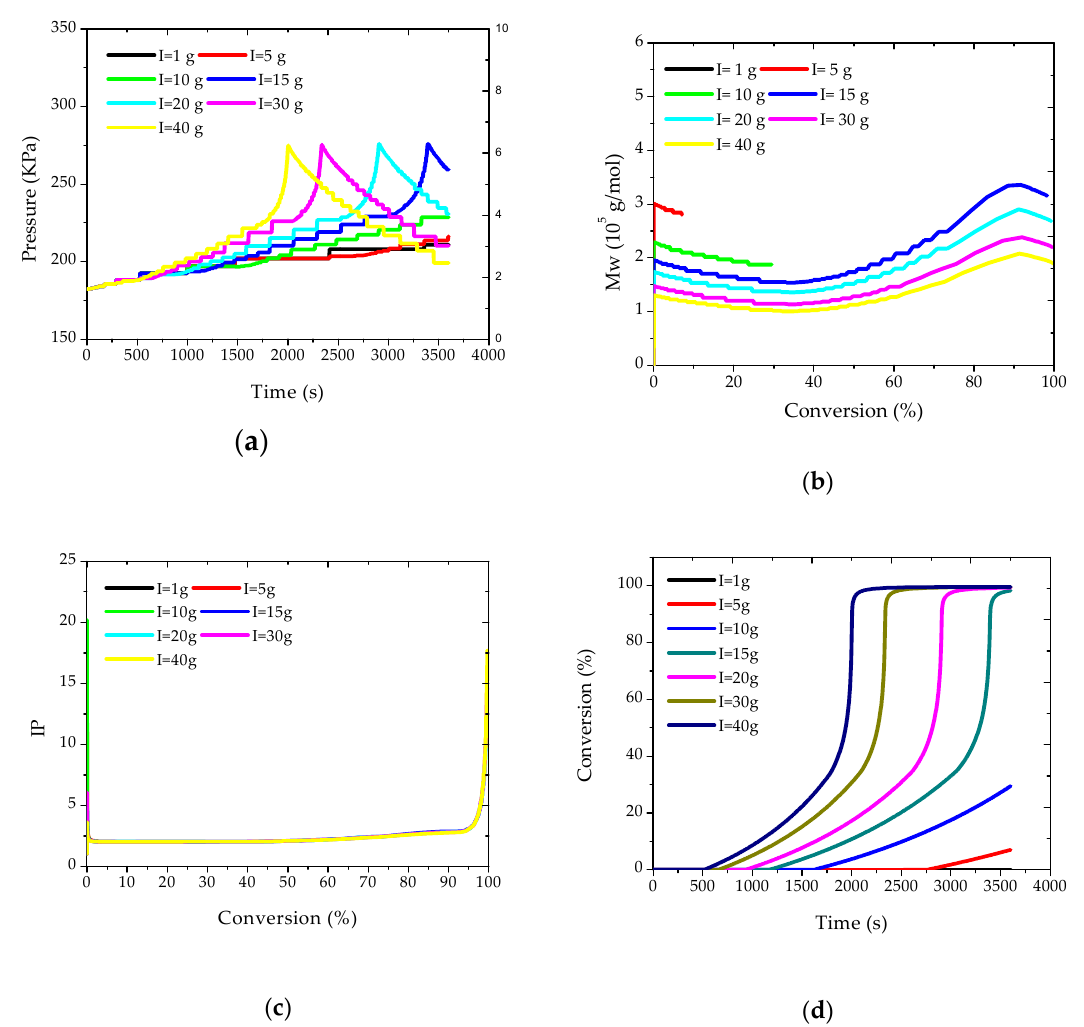
Figure 3. ( a ) Pressure; ( b ) Mw; ( c ) IP; and ( d ) conversion profiles for different initial loads of initiator.